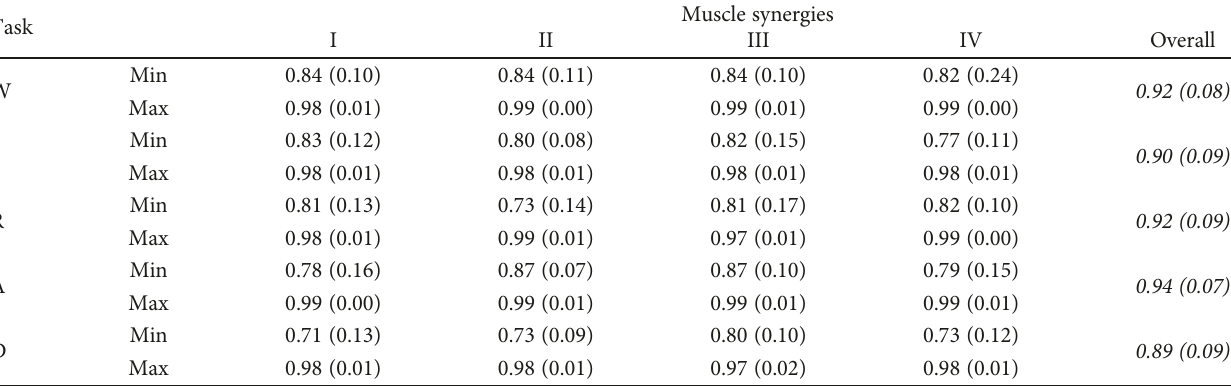
Table 4: Maximum and minimum and related standard deviation (SD) of WW cos considering all the synergies together are reported in